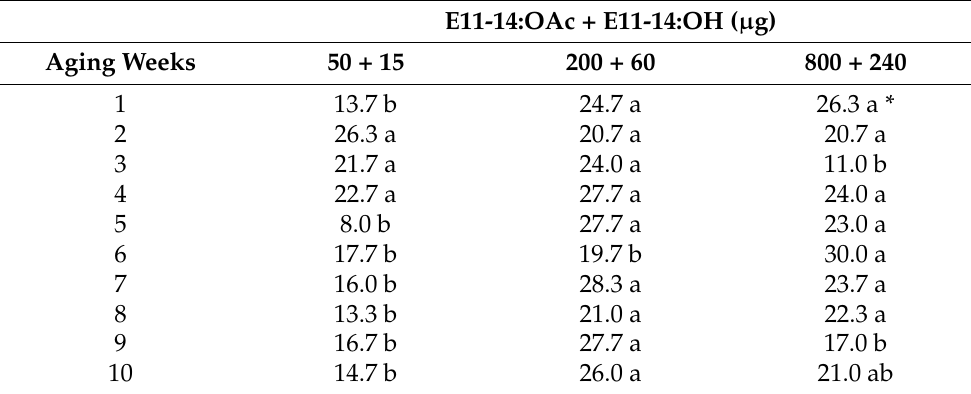
Table 1. Mean cumulative P. auraria catches in traps ( n = 3) within aging weeks for the three tested pheromone loads, Nancagua, central Chile, 18–23 February 2015.